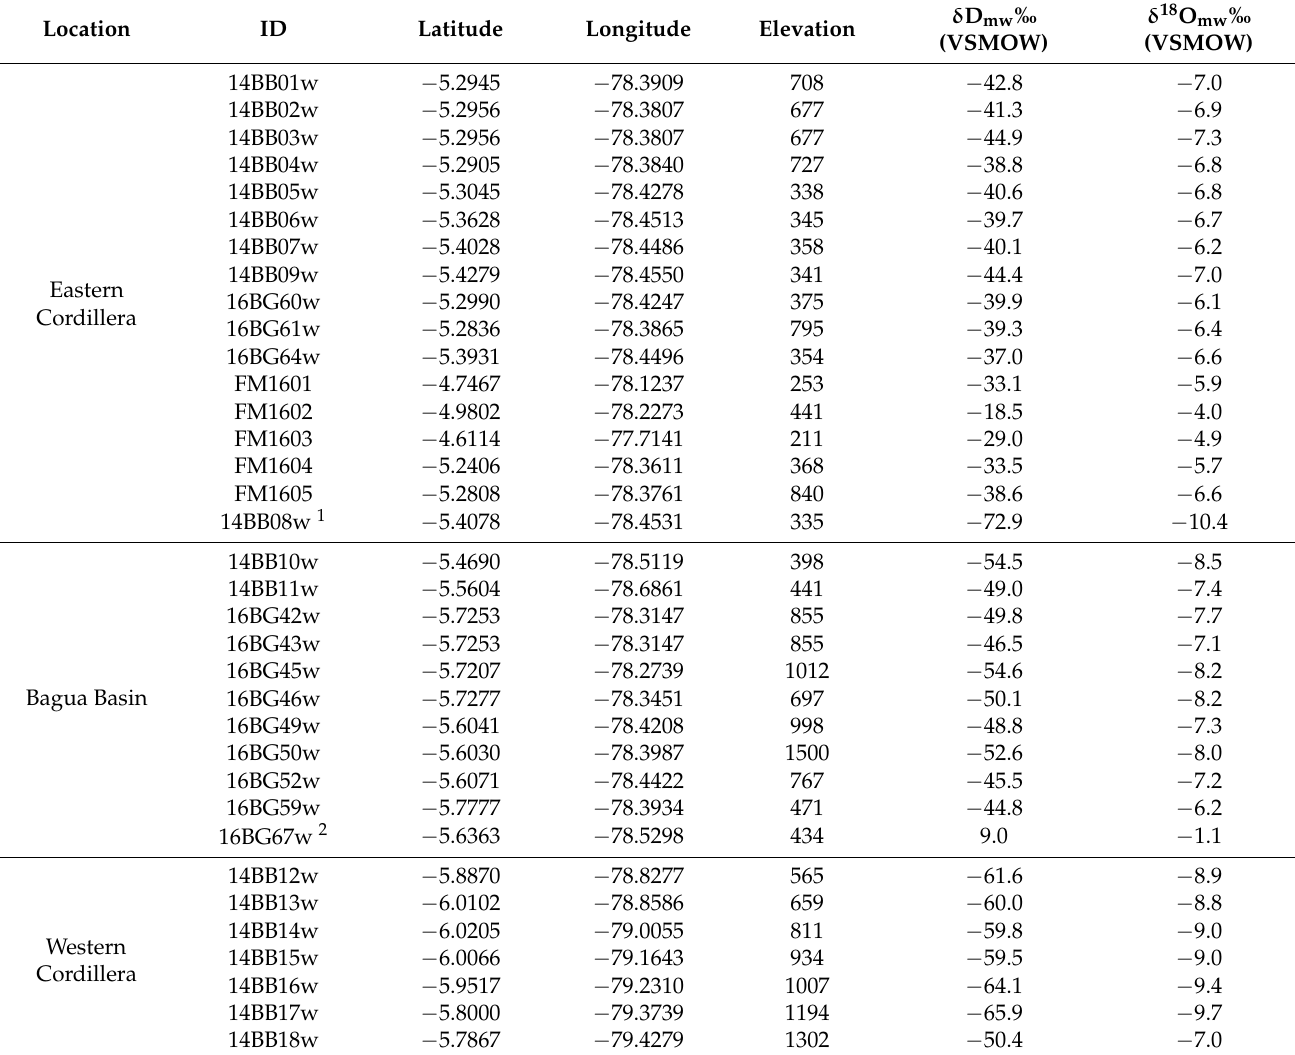
Table 1. δ 18 O mw and δ D mw values for sample streams and